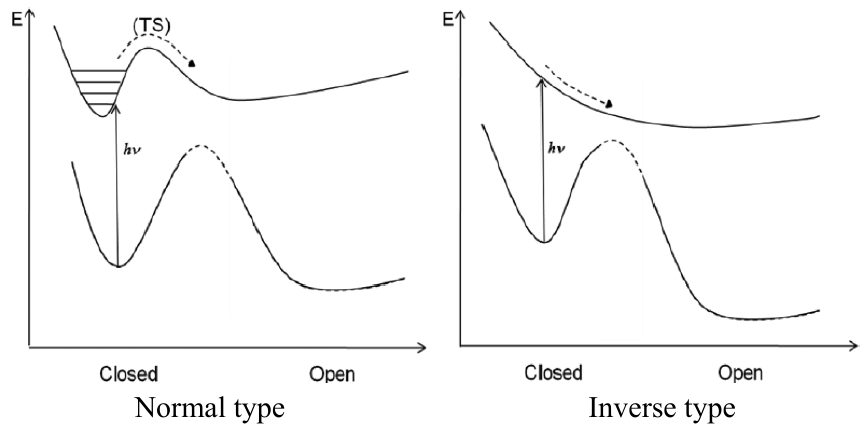
Figure 6. Schematic PES profiles for normal- and inverse-type DAEs.